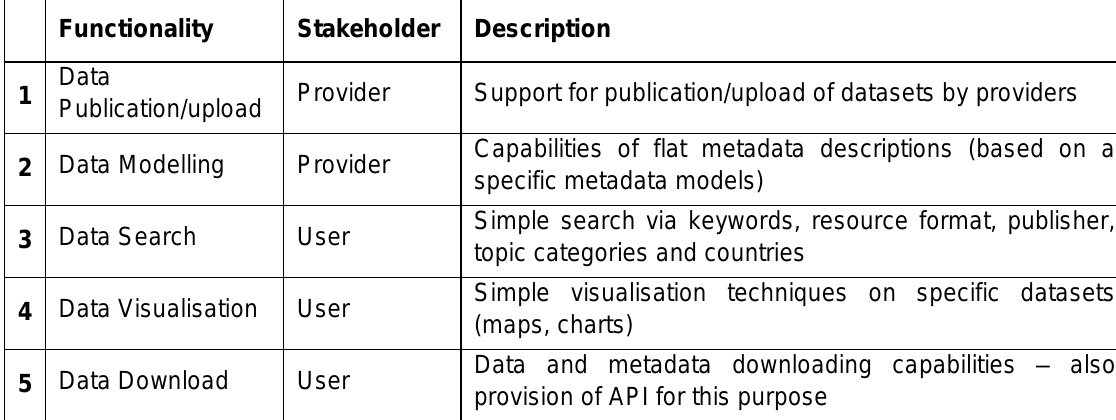
Table 1: Classical Functionalities